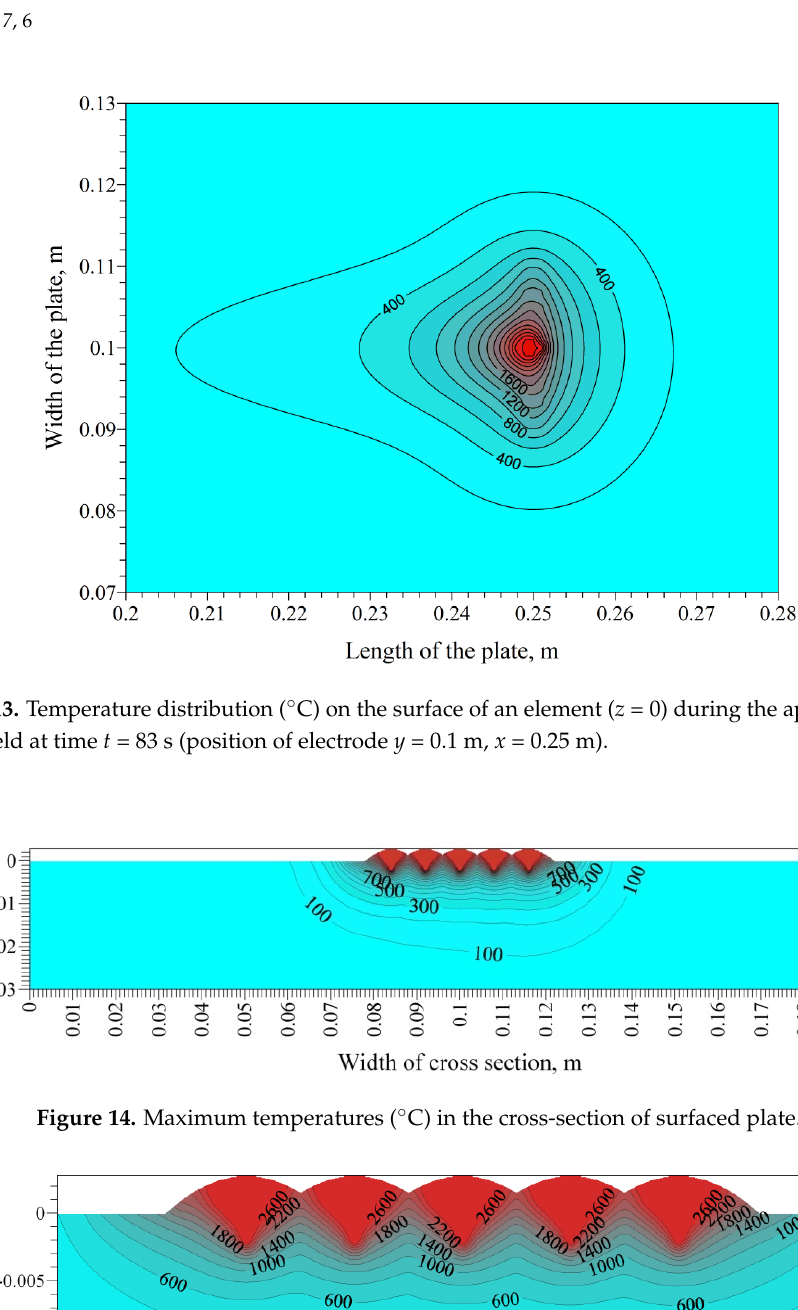
Figure 12. Temperature field (°C) in the longitudinal section on the axis of third weld ( y = 0.1 m) during application, at time t = 83 s (position of electrode x = 0.25 m).